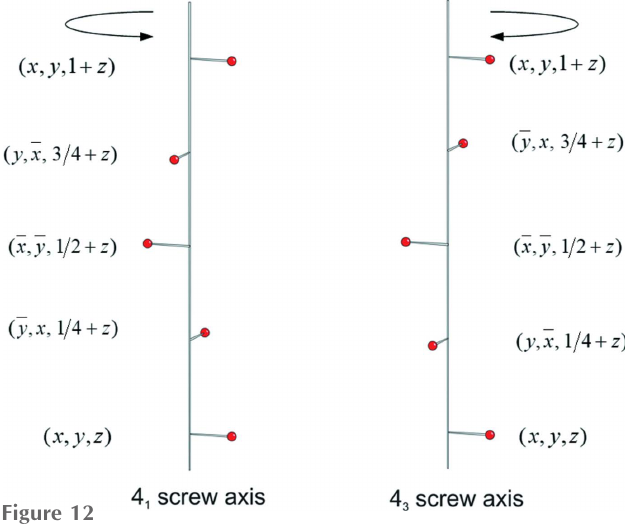
Figure 10 Slide 25, Chapter 1.